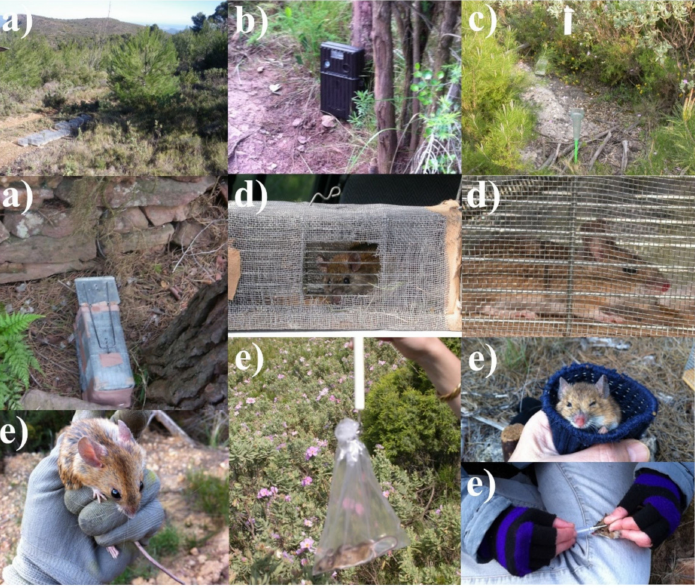
Figure 5. Some snapshots showing the most common tasks during surveys: trap preparation ( a ), camera trapping ( b ), temperature and rainfall measurement ( c ), captures ( d ), handling and marking of small mammals captured ( e